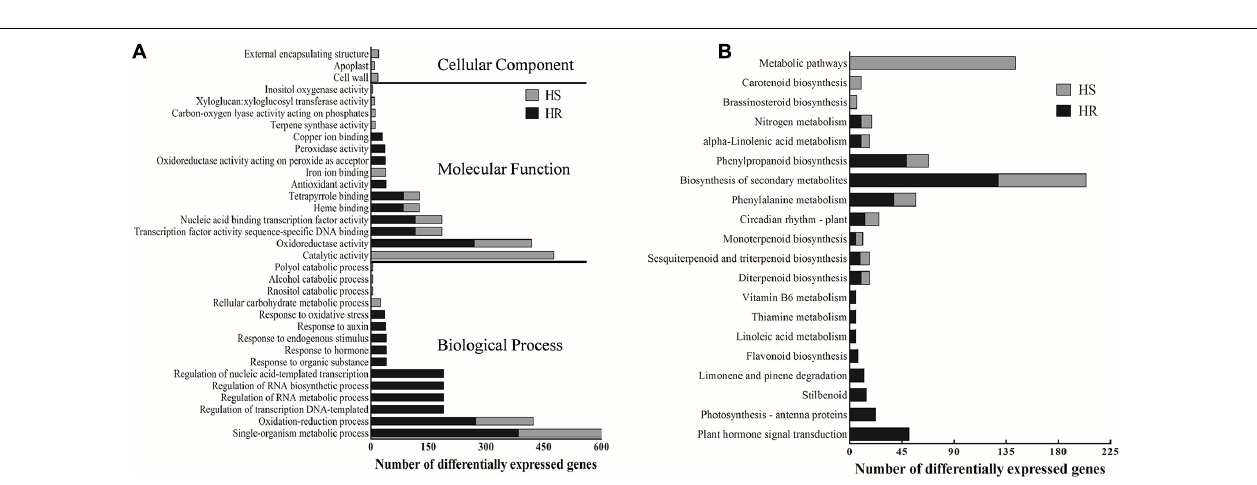
FIGURE 1 | Comparison of the number of genes differentially expressed in Shidalukang 1 (HR) and Junmian 1 (HS) at 12, 24, and 48 h after Verticillium dahliae infection. (A,B) The number of differentially expressed genes (DEGs) unique to or overlapping between each time point in (A) HR and (B) HS following V. dahliae infection. (C) The number of DEGs with different fold-change in HR and HS after V. dahliae infection.